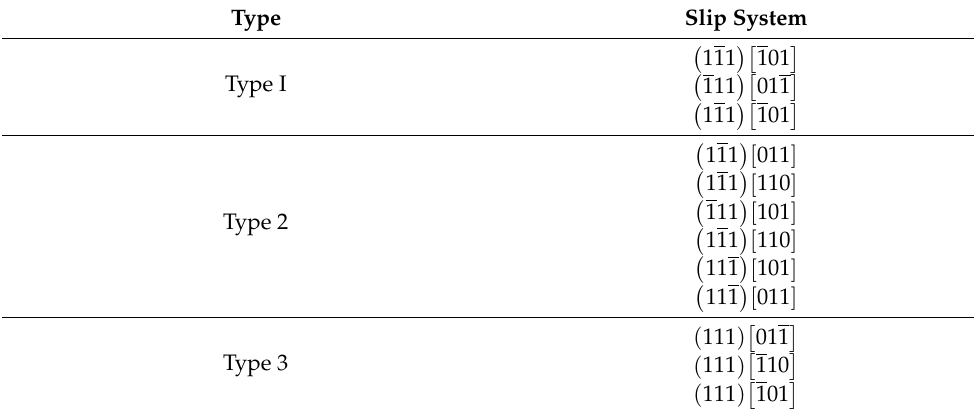
Table 2. A total of 12 slip systems for the present nt-Cu